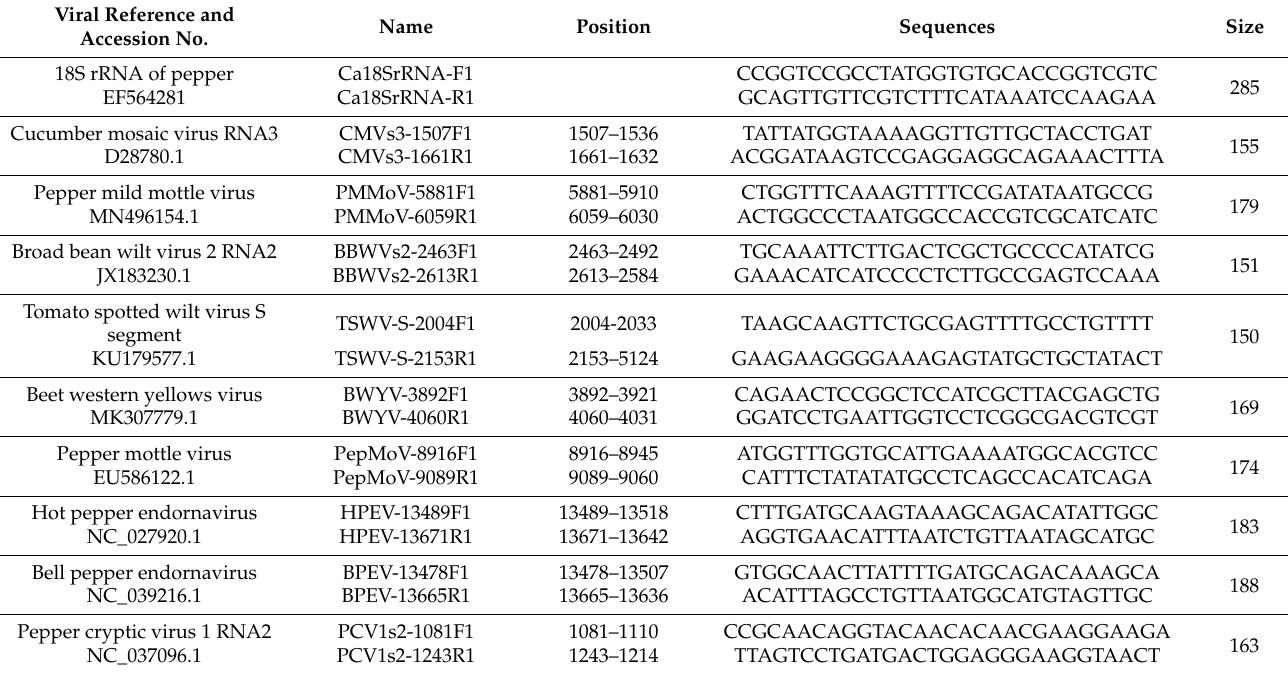
Table 2. Primer pairs used to detect viruses infecting pepper